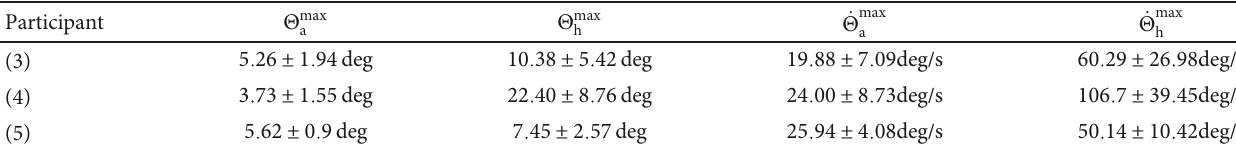
Table 1: Mean and standard deviation of the maximal absolute angle and angular velocity for the ankle and hip for all valid trials.